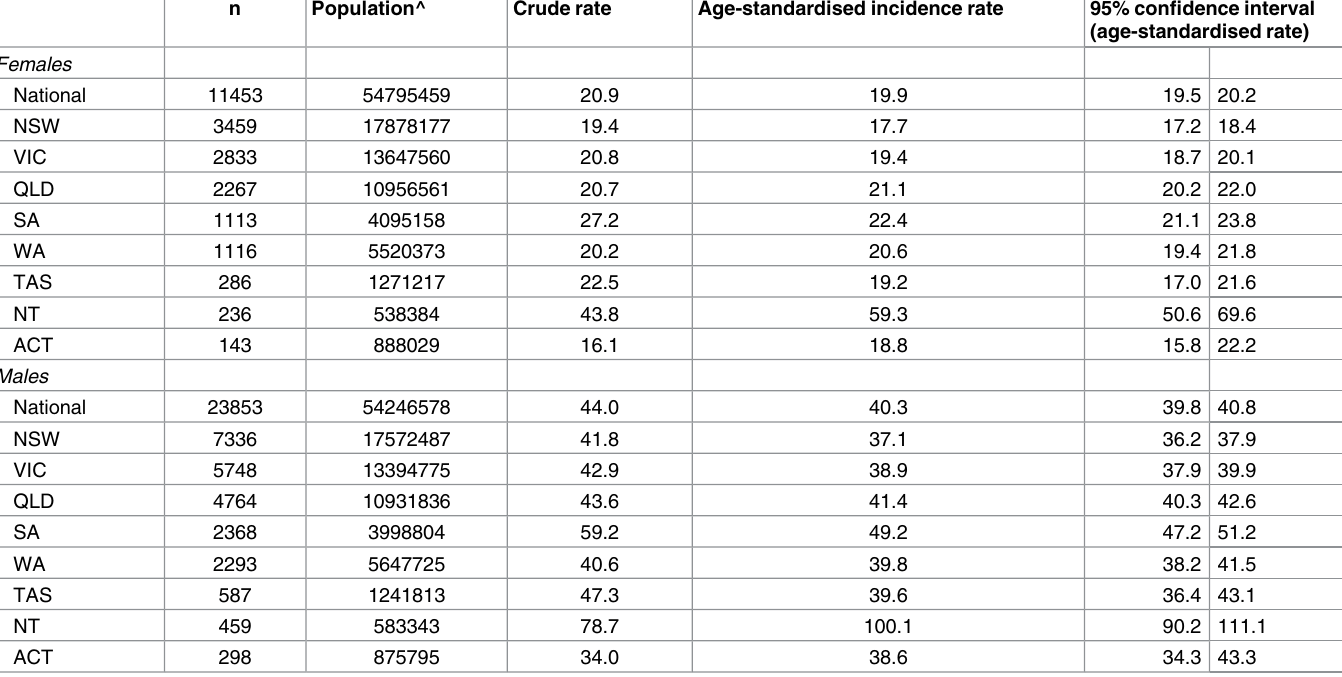
Table 2. Age-standardised incidence rate for males and females by nation and state/territory per 100,000person-years, from 2007–2008to 2011– 2012.